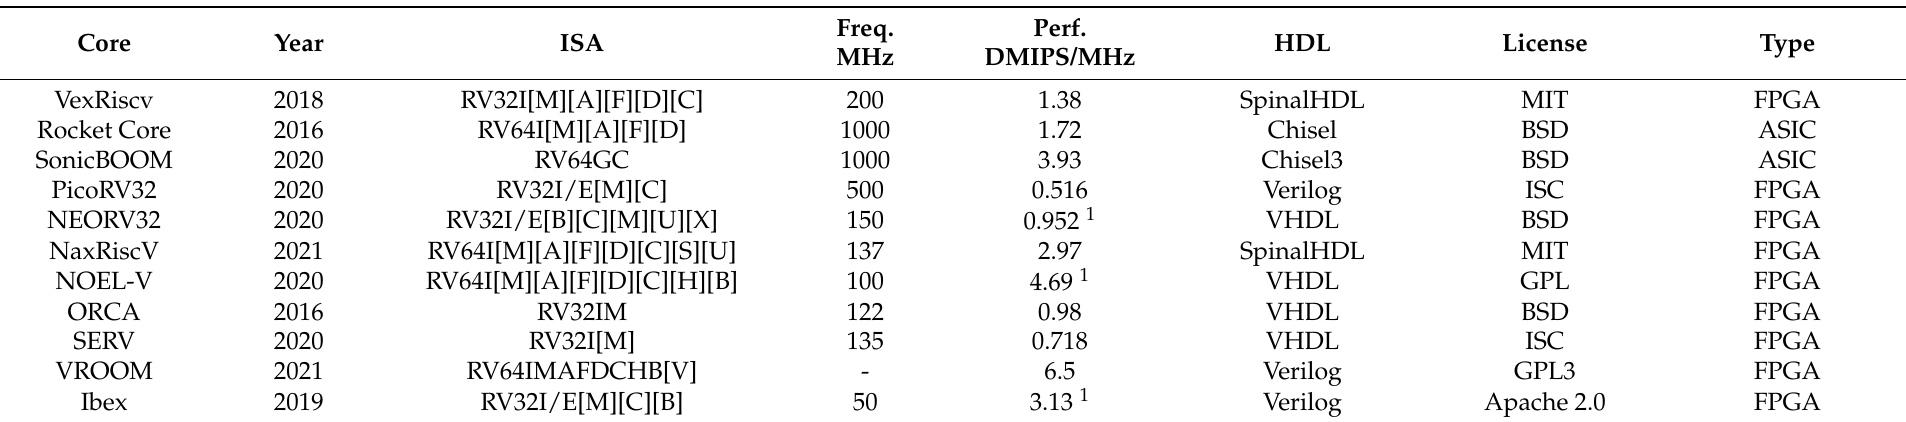
Table 2. RISC-V core implementations by the academic